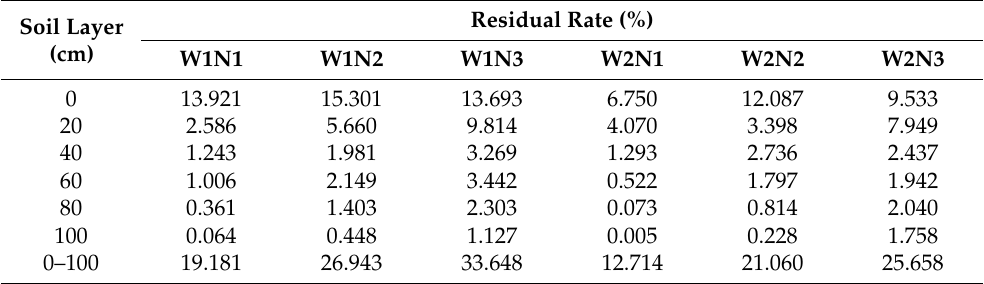
Table 3. Residual rate of 15 N fertilizer in each layer of the soil following harvesting. Soil Layer